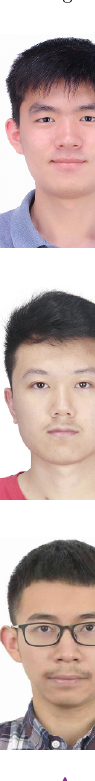
Fig. 3 Rendering by Instant-NGP implemented using JNeRF after training on an RTX3090 for 0.5 s, 1 s, and 5 s,